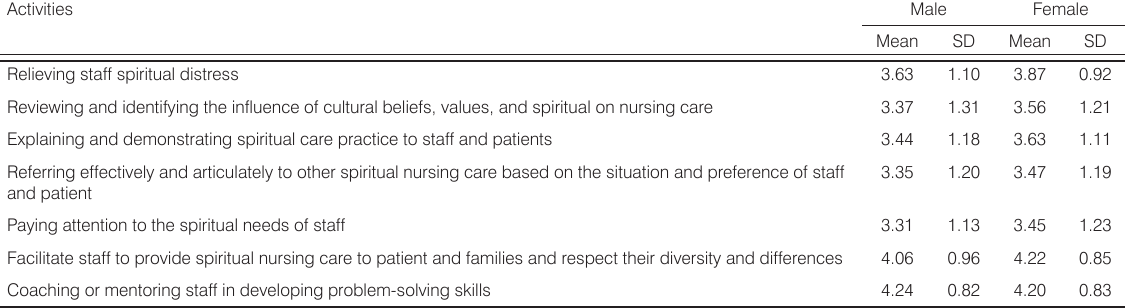
Table 3. Facilitating spiritual nursing care dimension of managerial competence according to gender ( N = 256).